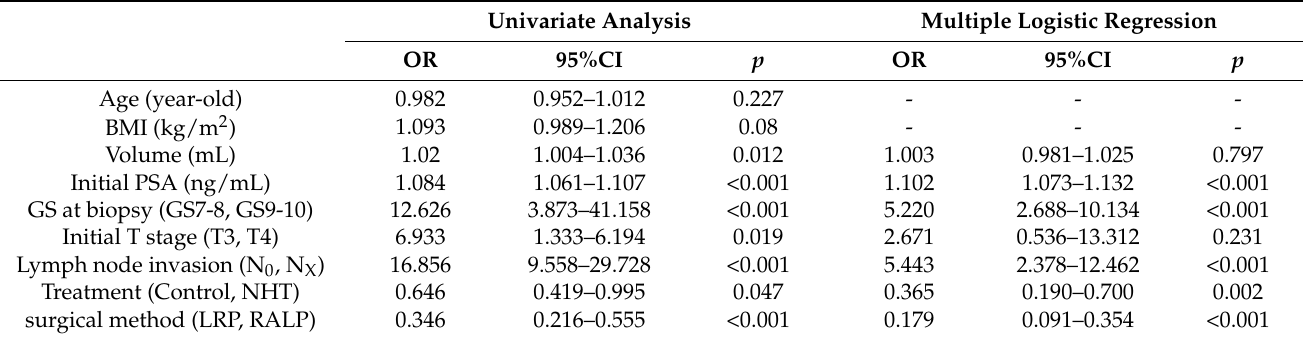
Table 5. Univariate and multiple logistic regression analysis of positive surgical margins in the overall